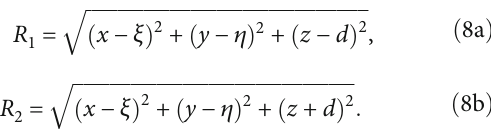
Figure 2: Schematic of the calculation model for additional stress induced by excavation